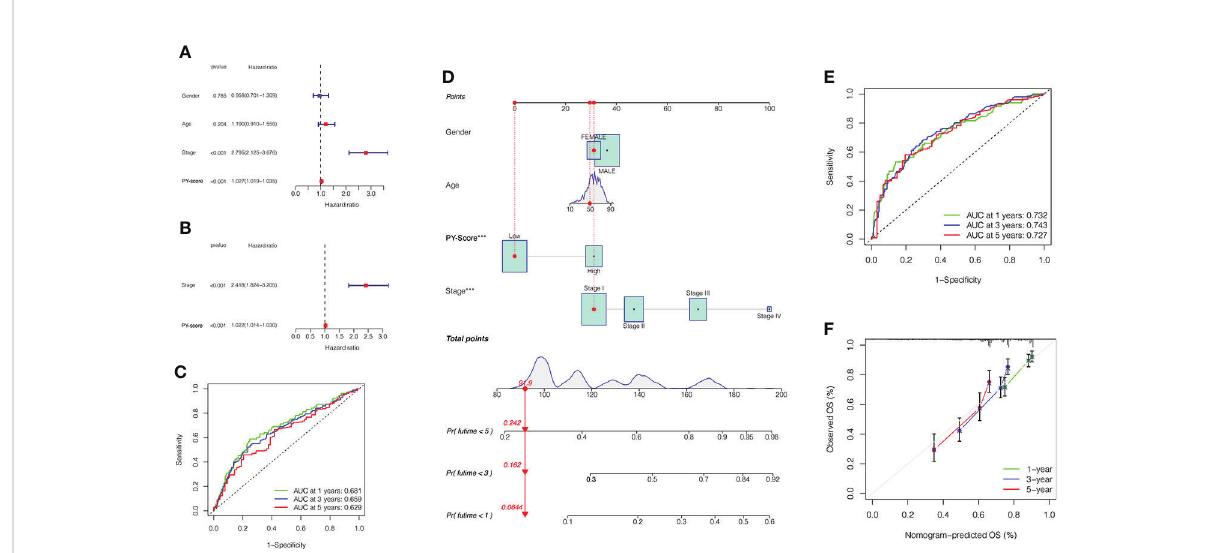
FIGURE 5 Prognostic value of PYS model for HBV-HCC patients. (A, B) Univariate (A) and multivariate (B) Cox regression analyses for the PYS model. (C) ROC curves with time dependency based on PYS. (D) A novel nomogram for predicting HBV-HCC prognosis based on clinical characteristics and PYS. (E) ROCs for the survival nomogram ’ s 1-, 3-, and 5-year survival time. (F) Calibration curve of the survival nomogram. PYS, pyroptosis